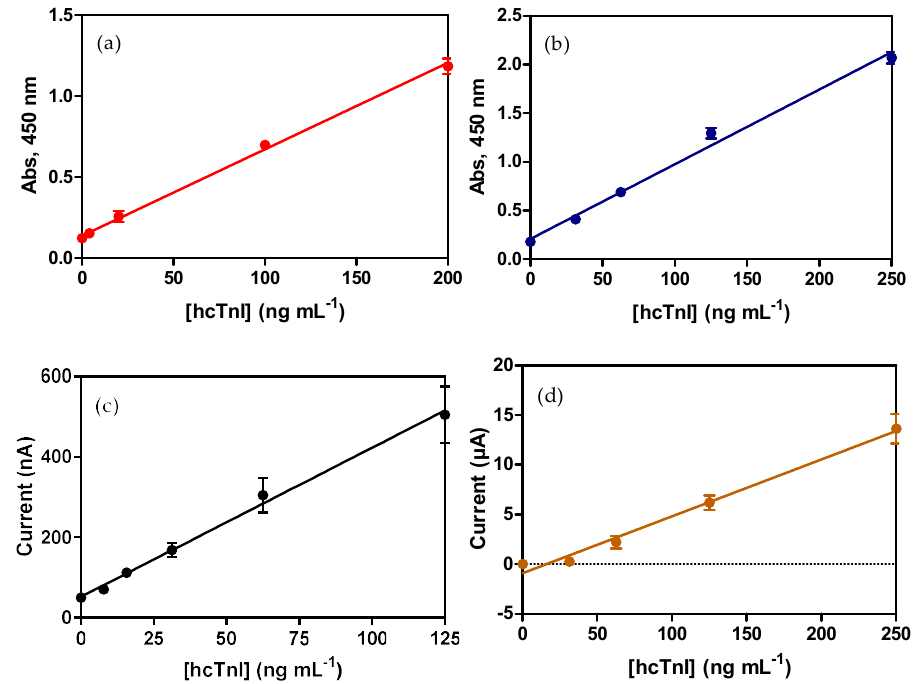
Figure 2. Calibration curves for the different immunoassays developed for the detection of hcTnI. ( a ) ELISA calibration curve for hcTnI in buffer using the immunoreagent produced. As220 was used as a capture antibody at a dilution of 1/16,000, and pAb221-B at 2.5 µ g mL − 1 . Each point was the average of at least two-well replicates, and the assay was run on two different days. ( b ) mELISA calibration curve for hcTnI in buffer using the different bioconjugates prepared as described previously. MB-pAb220 was used as a capture probe at 0.1 mg mL − 1 and pAb221-B as a detection antibody at a concentration of 0.5 µ g mL − 1 . SAv-HRP was used at a concentration of 0.17 µ g mL − 1 . Each point was the average of at least two well replicates, and the assay was run on two different days. ( c ) AMIS calibration curve for hcTnI detection in buffer. MB-pAb220 was used as a capture probe at 0.1 mg mL − 1 and pAb221-B as a